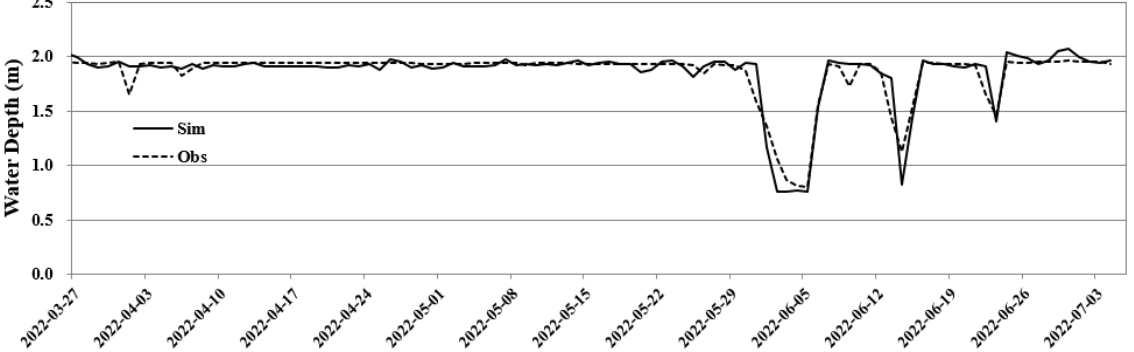
Figure 8. Comparison of simulated and observed water depth in sand dam.